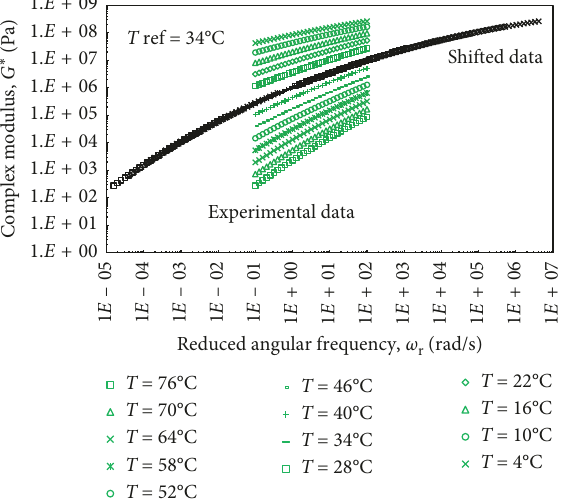
vs. ω r )—35/50 pen. ∗